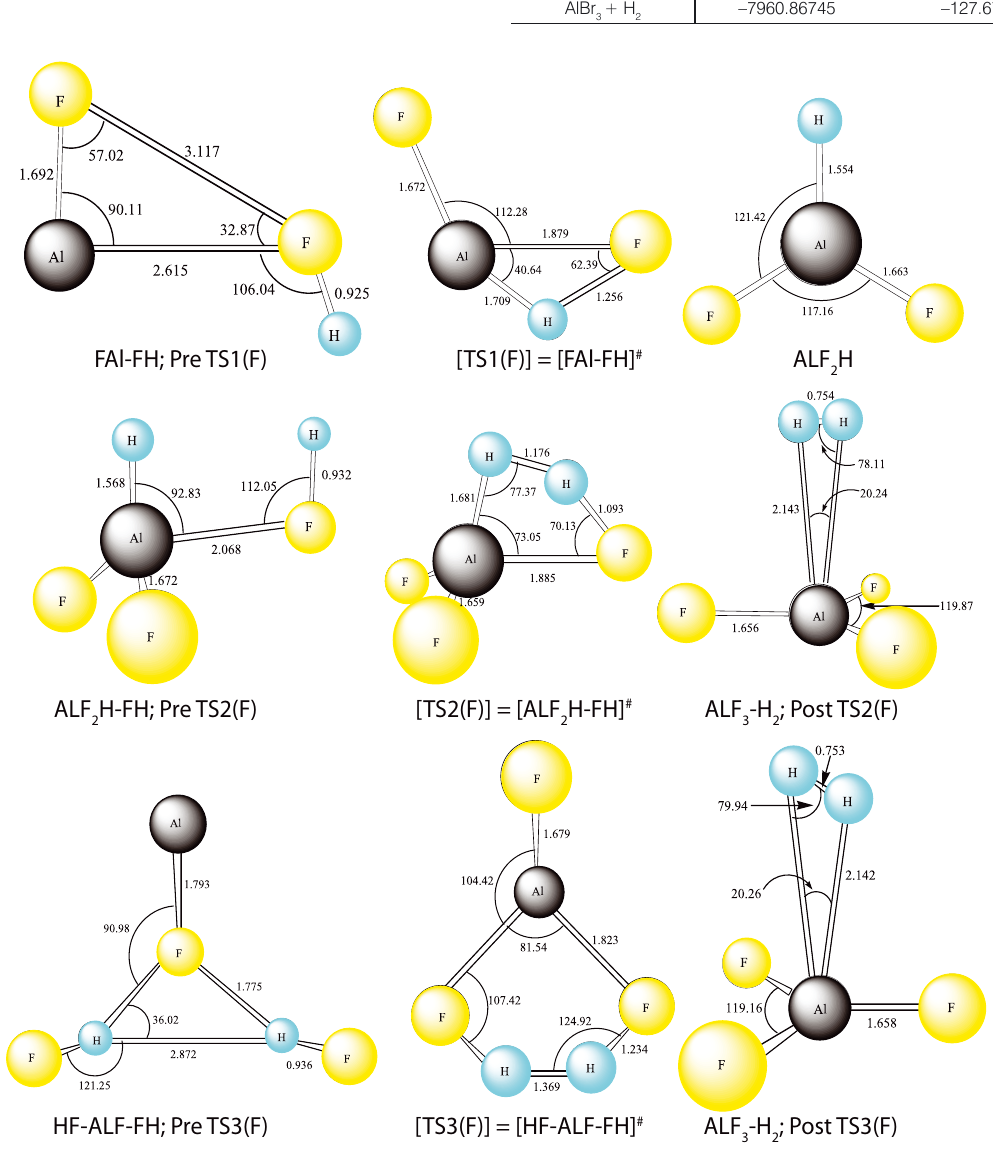
Figure 3. Optimized geometries for X = F. All species are C